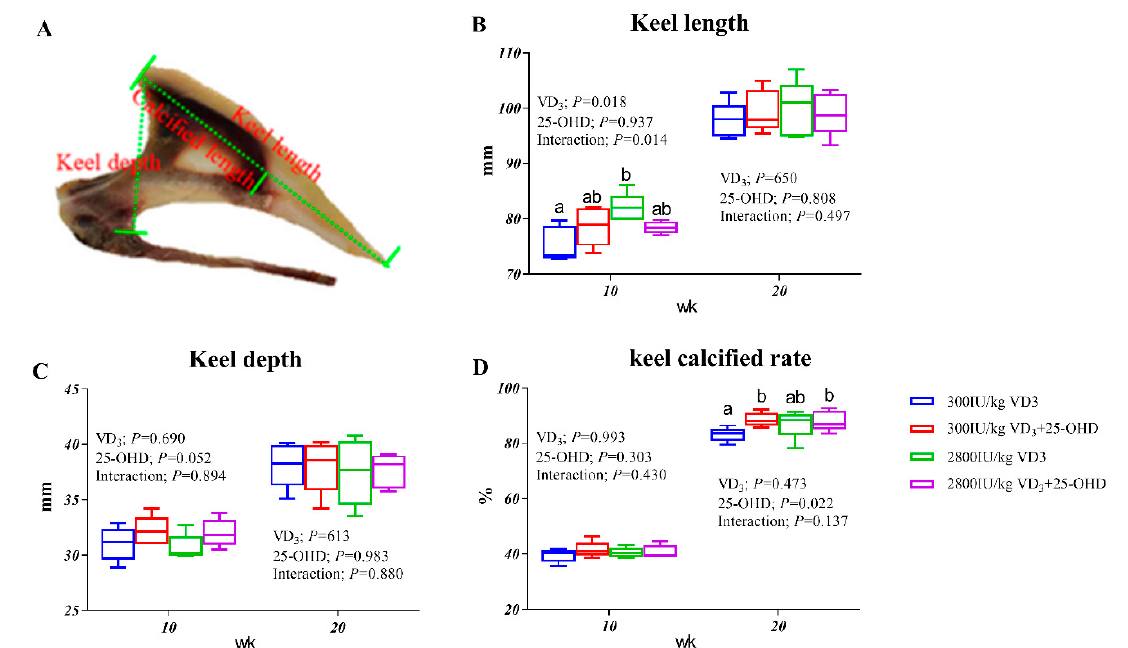
Figure 2. Effects of dietary VD 3 level and 25-OHD on the keel development and calcification of laying hens. ( A ) Picture showing the measure location of keel depth and calcified rate; ( B ) keel length; ( C ) keel depth; ( D ) keel calcified rate. a–c a,b Mean values with different letters are significantly different.